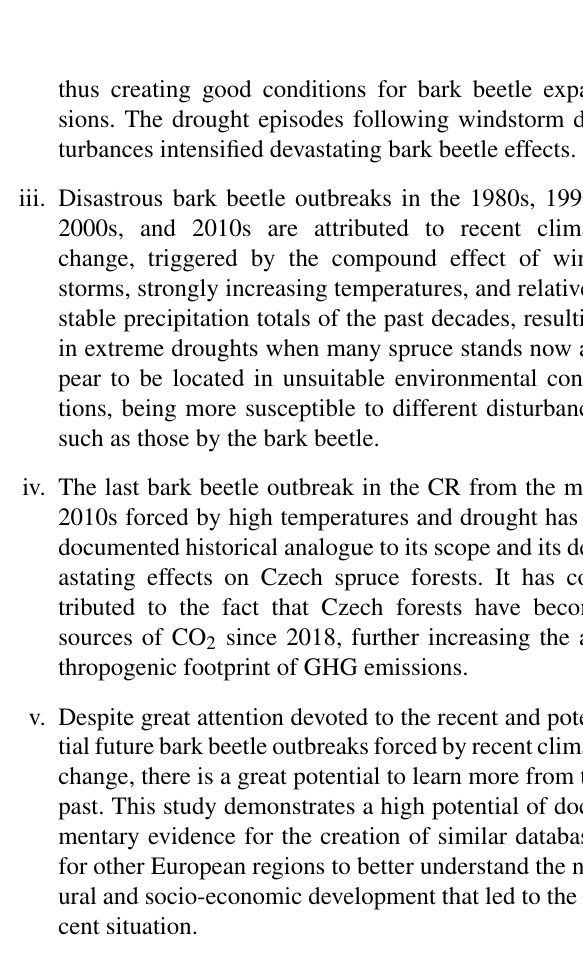
Figure 13. Comparison of bark beetle outbreaks and windstorms in the Czech Republic during the 1964–2021 period (NBBO – notable bark beetle outbreak): (a) volumes of annual salvage felling attributed to windstorms (1) and bark beetle infestation (2); (b) annual frequency of severe windstorms for January–March and